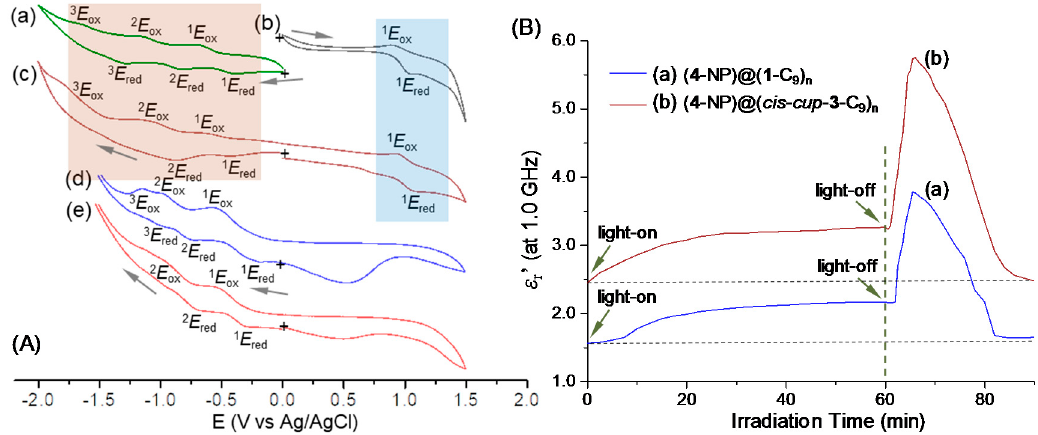
Figure 5. ( A ) Cyclic voltammograms (CV) of (a) C 60 >, (b) cis ‐ cup ‐ tris(DPAF ‐ C 9 ), (c) C 60 (>DPAF ‐ C 9 ) ( 1 ‐ C 9 ), (d) cis ‐ cup ‐ tris[C 60 (>DPAF ‐ C 9 )] (with no light), and (e) cis ‐ cup ‐ tris[C 60 (>DPAF ‐ C 9 )] (after white LED light irradiation for 30 min) at different voltages vs Ag/Ag + in a solution concentration of 1.0 × 10 − 3 M in CH 3 CN ‐ CH 2 Cl 2 , containing ( n ‐ butyl) 4 N + ‐ PF 6 − electrolyte (0.2 M), using Pt as working and counter electrodes and Ag/AgCl as the reference electrode at a scan rate of 10 mV/s. ( B ) Irradiation time ‐ dependent relative dielectric constant ( ε r ’) amplification of trilayered core ‐ shell nanoparticles of (a) ( γ ‐ FeO x @AuNP)@[C 60 (>DPAF ‐ C 9 )] n ( 6 ‐ NPs) and (b) ( γ ‐ FeO x @AuNP)@{ cis ‐ cup ‐ tris[C 60 (>DPAF ‐ C 9 )]} n ( 5 ‐ NPs) at the frequency of 1.0 GHz. White LED light irradiation period was 60 min.